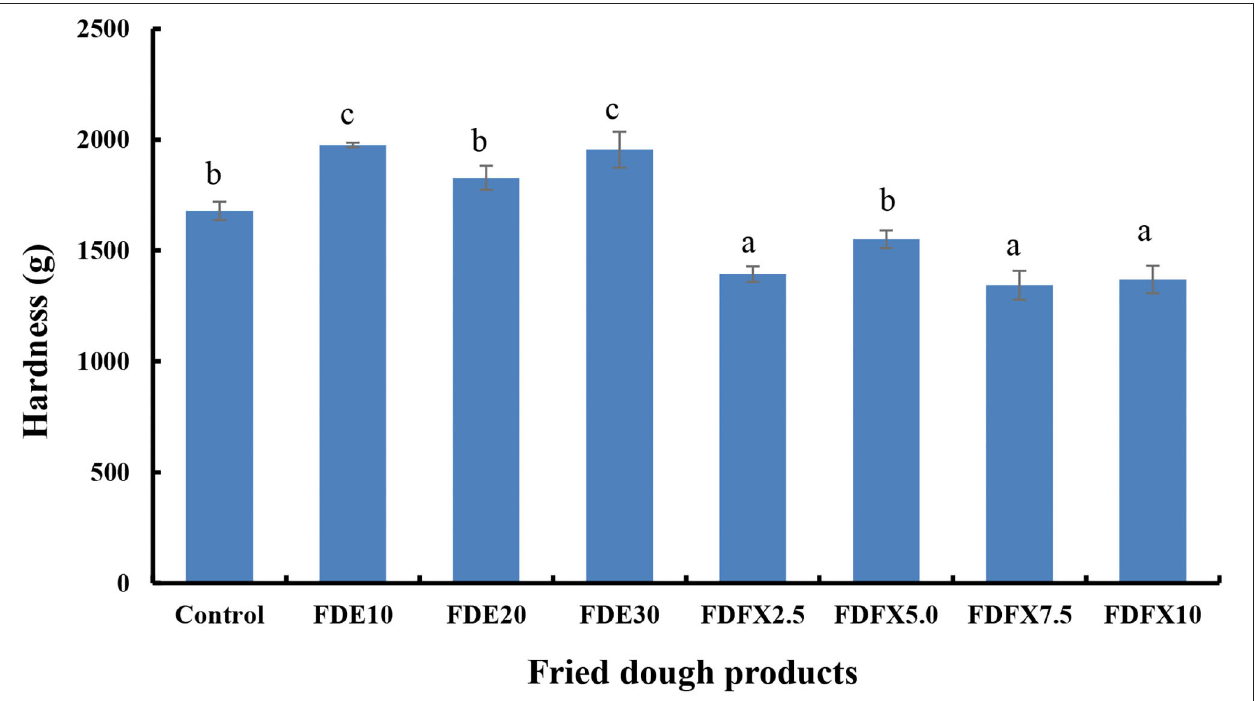
FIGURE 1 | Hardness (g) of fried dough products. Results were presented as mean ± standard deviation ( n = 3). Superscripts were assigned to show significant differences ( p < 0.05) with an increase in egg/flaxseed powder using Duncan multiple range test. FDE = egg-enriched fried dough, FDFX = flaxseed powder-enriched fried dough.